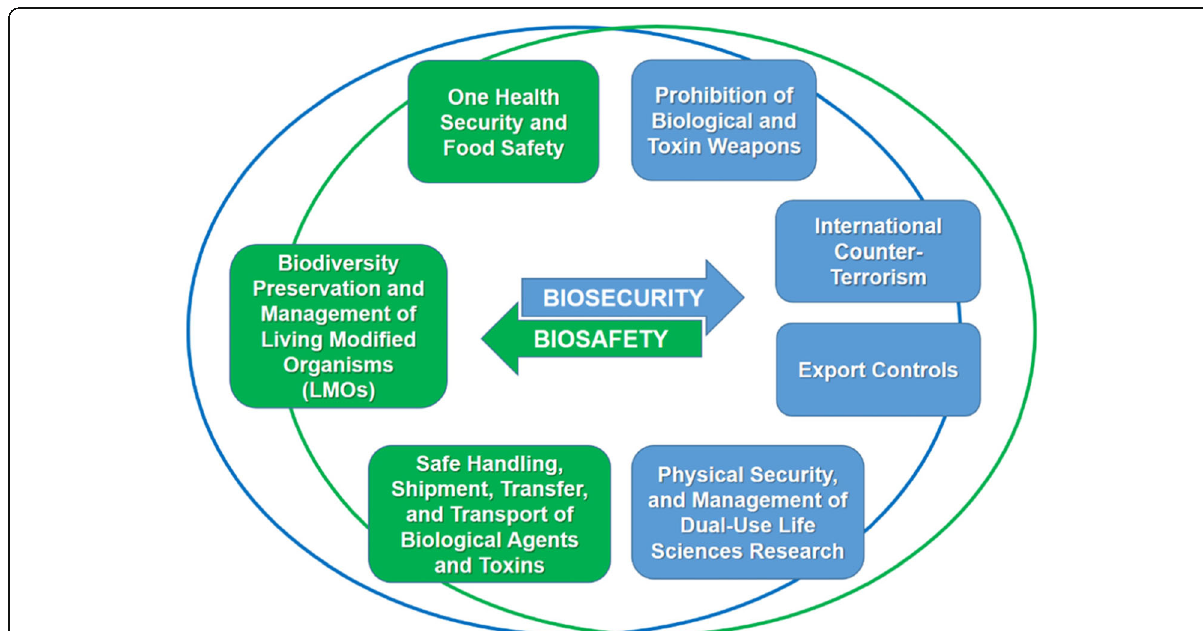
Fig. 1 The Web of Prevention for Biosafety and Biosecurity. Source: Authors. The figure has not previously been published. An earlier version of this figure appears in Novossiolova et al. 2019